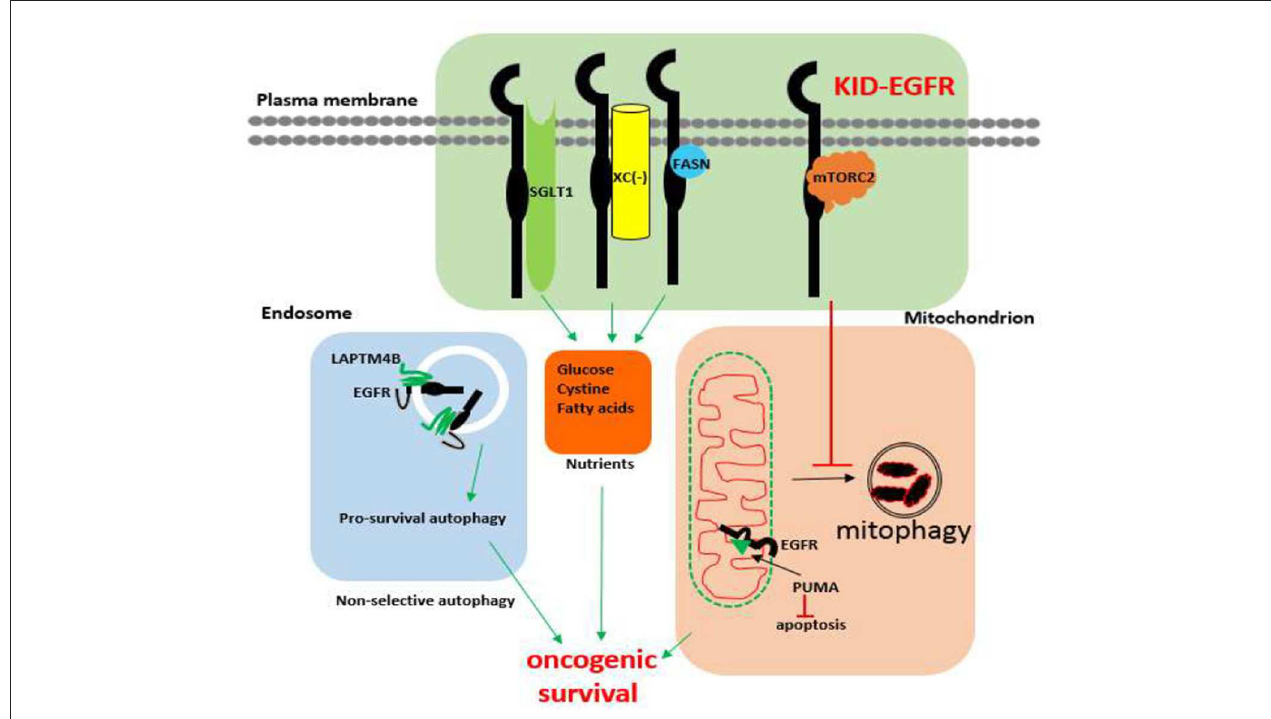
FIGURE 1 | Known kinase-independent functions of EGFR in cancer cells. Currently known kinase-independent (KID) functions of EGFR locate at three functional domains of cancer cell. One is in the plasma membrane where EGFR interacts with SGLT1, Xc − , fatty acid synthase (FASN), and the mTORC2 complex to support transportation of glucose, cystine, de novo fatty acid synthase, and repressing mitophagy, respectively. The second function domain is the endosomal autophagy machinery where kinase inactive EGFR promotes pro-survival autophagy. The third domain is the mitochondrial domain where kinase inactive EGFR interacts with PUMA to inhibit apoptosis. KID-EGFR is oncogenic and pro-survival.